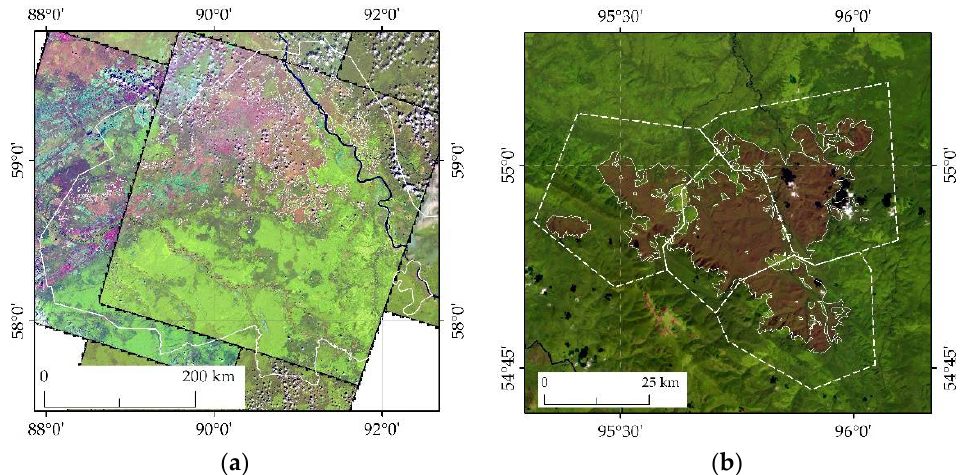
Figure 1. Overview of forests disturbed by silk moth, in ( a ) EnP for 2020; ( b ) in IrP for 2020.